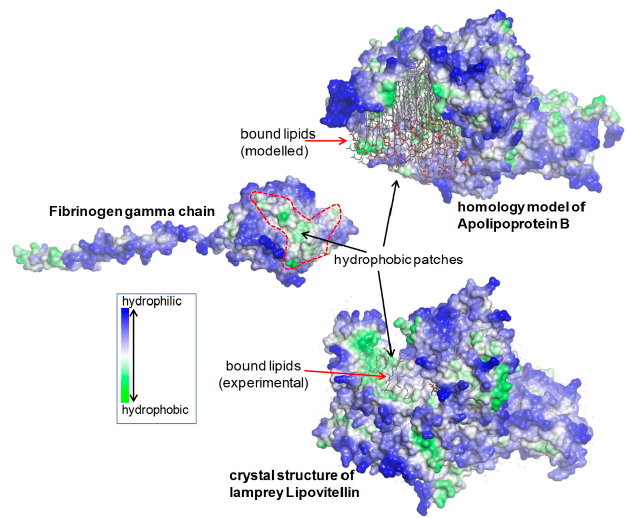
Figure 3. Exposed hydrophobic region in the unpolymerized fibrinogen gamma chain as a potential site for abnormal interactions with APOB. A fibrinogen γ monomer (PDB 1FZB) is shown together with the homology model of APOB with bound lipids [13] and the crystal structure of the closest structurally characterized homologue of the latter, lipovitellin (PDB 1LSH). Molecular surfaces are colored according to the residue hydrophobicity. The partial lipid structures bound to lipovitellin are present in the crystal structure. A failure in fibrinogen polymerization leaves exposed a large hydrophobic region in the gamma chains, which might give rise to undue interactions with lipids and with the hydrophobic regions of APOB and other proteins.